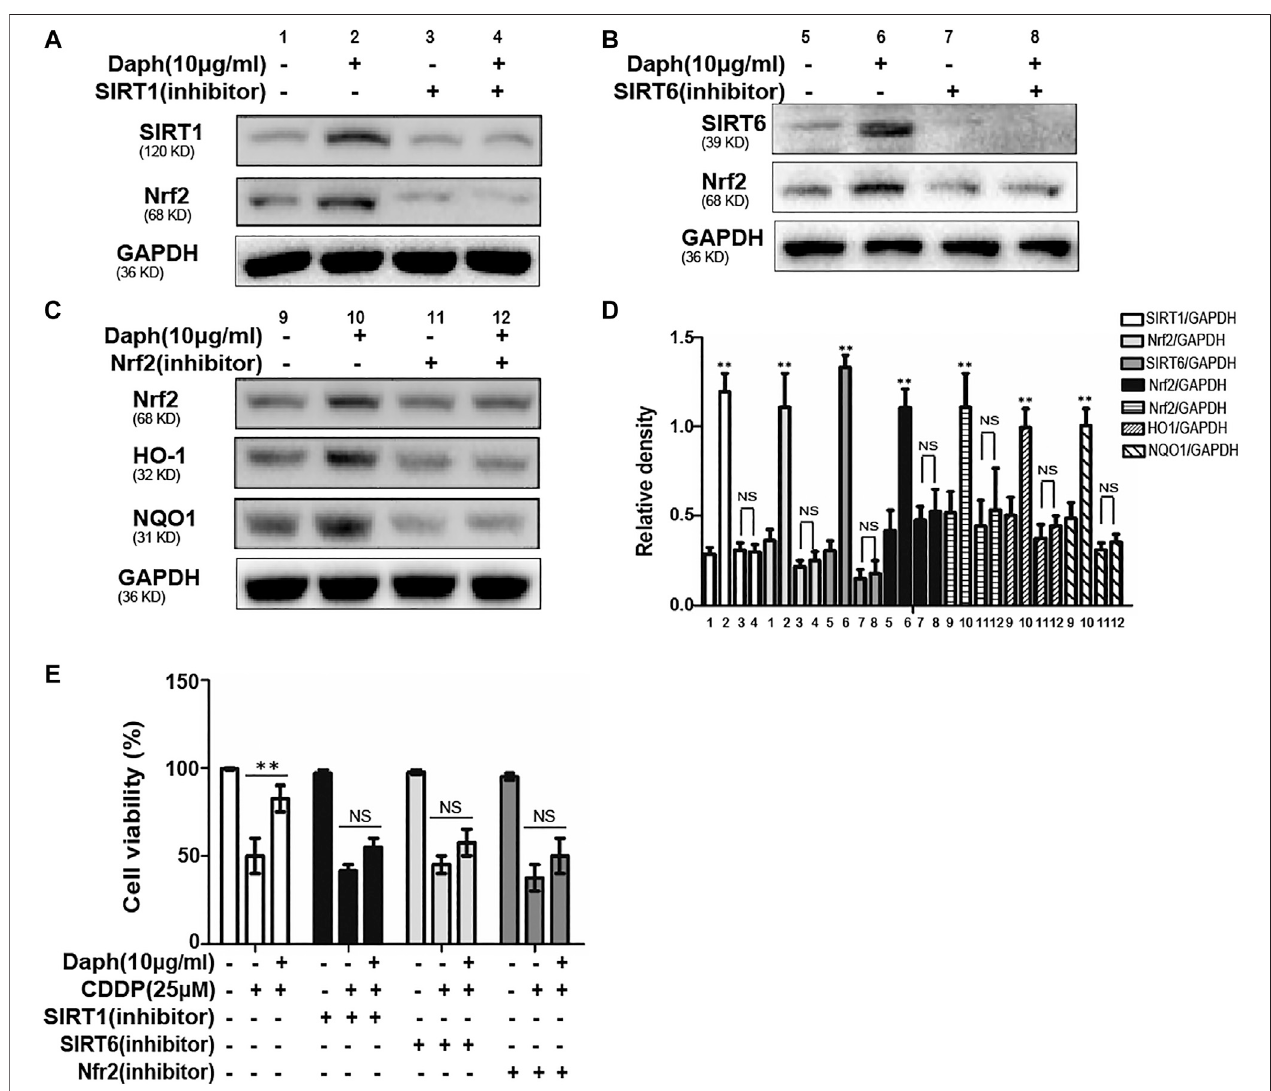
FIGURE 9 | Daph regulates Nrf2 through SIRT1 and SIRT6 activation and attenuated CDDP-induced cytotoxicity in HK2 cells. (A – D) Western blots analysis showingtheexpressionlevelsofSIRT1,SIRT6,Nrf2,HO1andNQO1afterthetreatmentofSIRT1,SIRT6andNrf2inhibitorsinHK-2cells. (E) EffectsofDaphonCDDP- inducedcell viability withSIRT1, SIRT6 and Nrf2inhibitors.Data arepresented asthemean ± SEM, and arerepresentative ofthree independent experiments. ** p < 0.01 vs. the control group; NS, not signi fi cant.